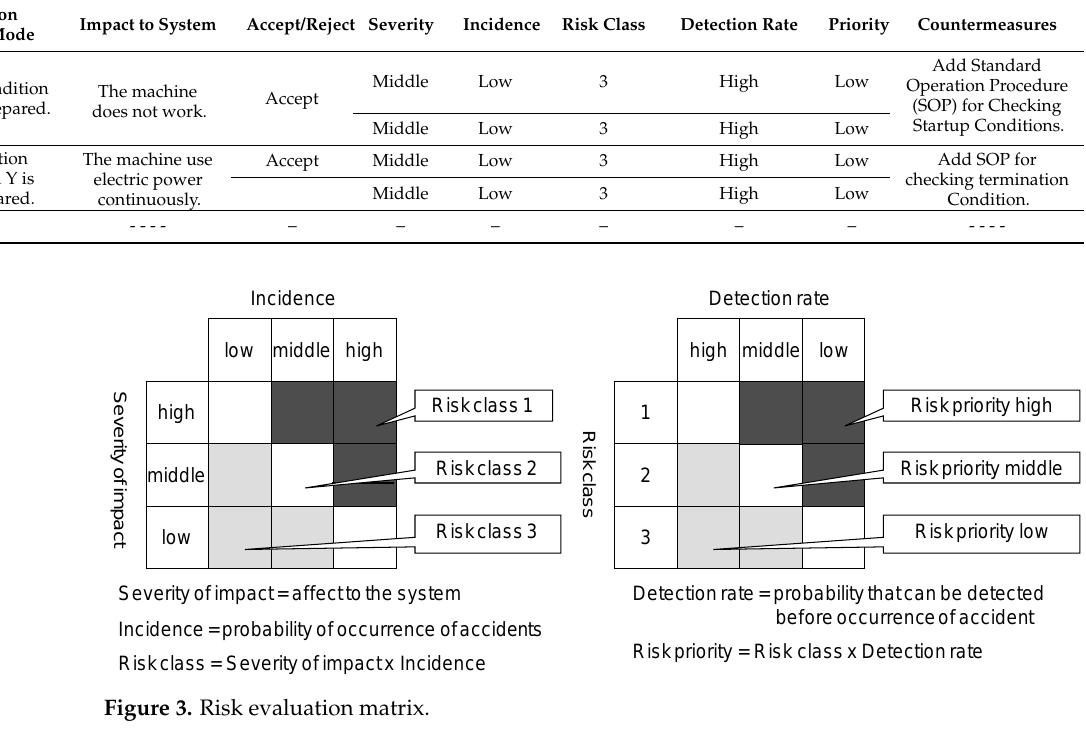
(SOP) for Checking Startup Conditions.Middle Low